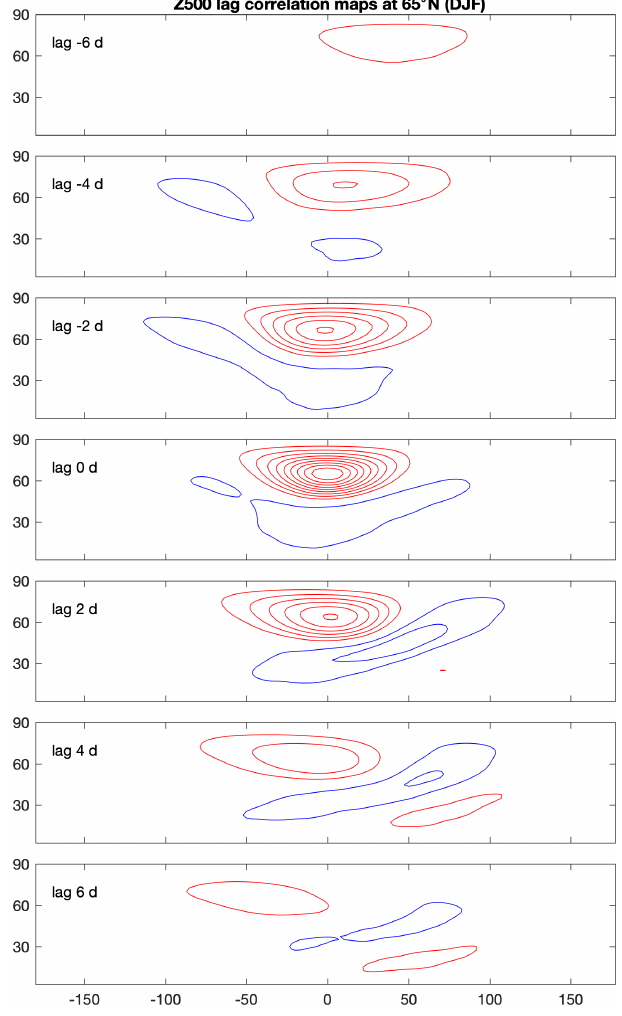
Figure 8. Lag correlation analysis of daily mean Z 500 from the NCEP2 reanalysis. Shown is the average of 12 correlation maps calculated at 65 ◦ N for 12 base points equally spaced in longitude. The contour interval is 0.1 with the zero correlation lines